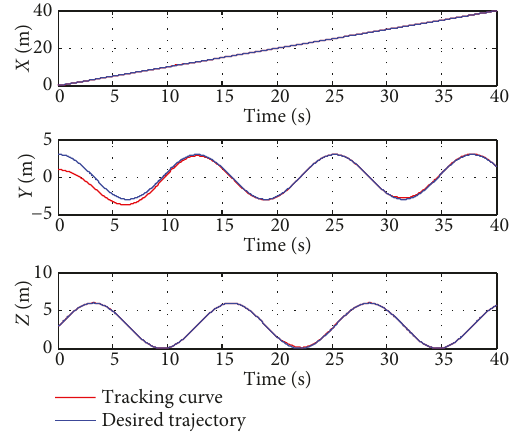
Figure 11: The curve of trajectory tracking.